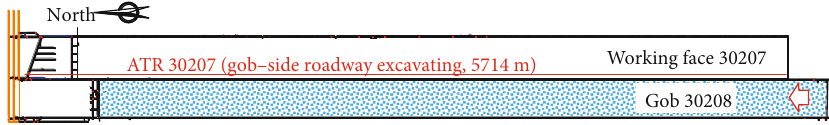
Figure 1: Roadway location and mining